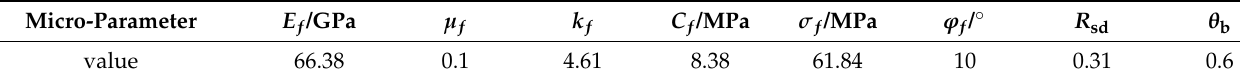
Figure 8. Transjuane Sandstone specimen after uniaxial failure. Table 6. Initial determination of microscopic parameters.